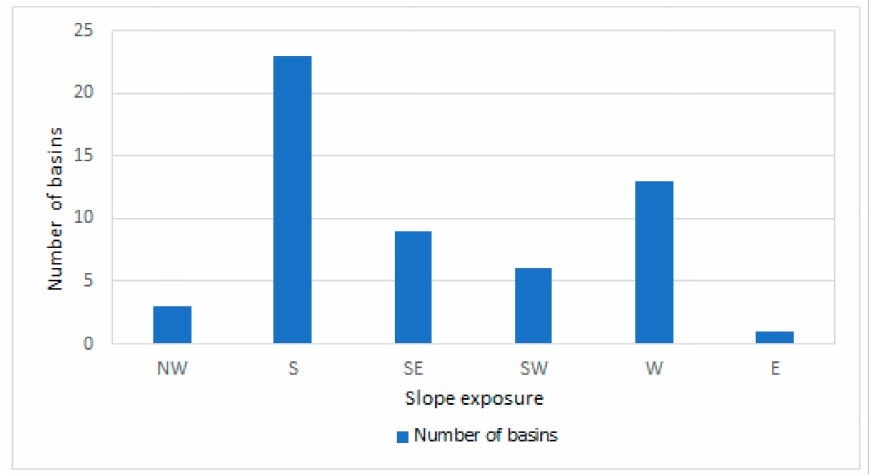
Figure 9. Relationship between the slope aspect direction and mapped badlands in the study